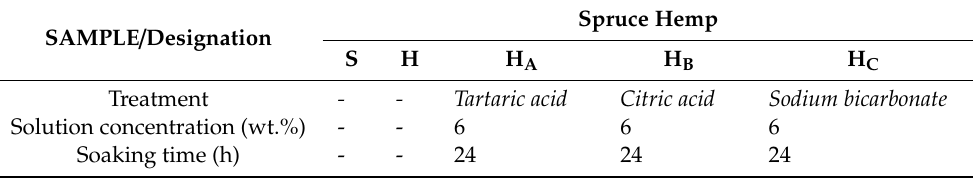
Table 1. Spruce strands and hemp shive modifications (S—spruce strands, H—untreated hemp shive, H A —hemp shive after tartaric acid treatment, H B —hemp shive after citric acid treatment, H C —hemp shive after sodium bicarbonate